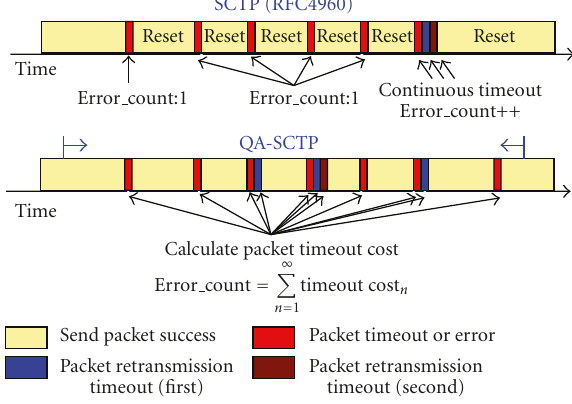
Figure 4: Quality-aware SCTP path failure count